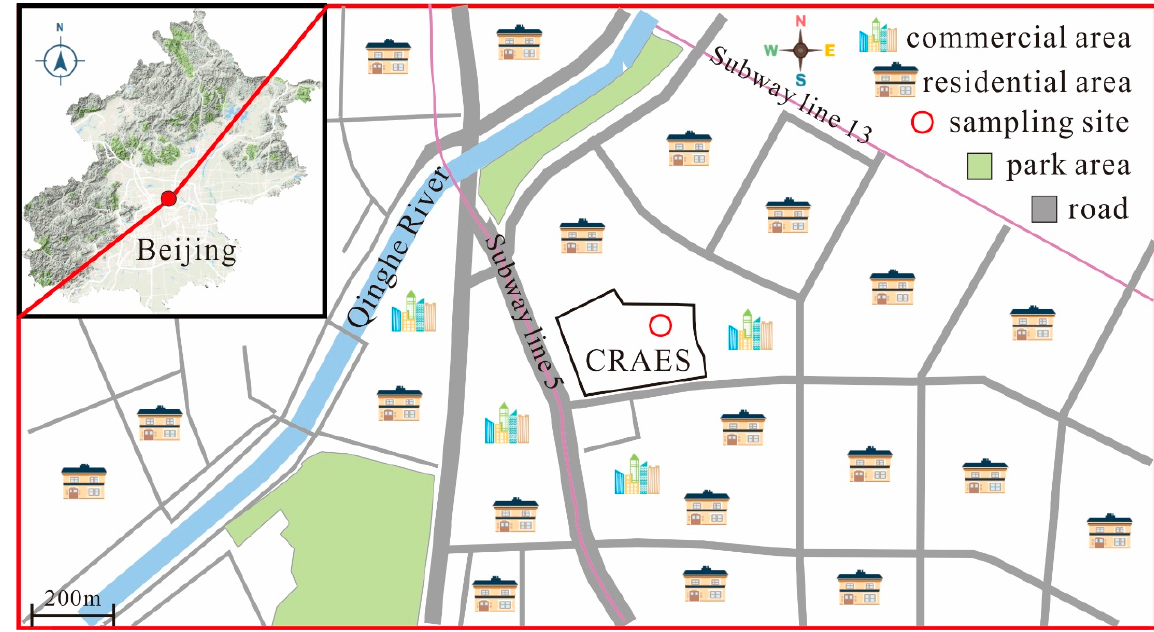
Figure 1. Location of the monitoring site and its surroundings